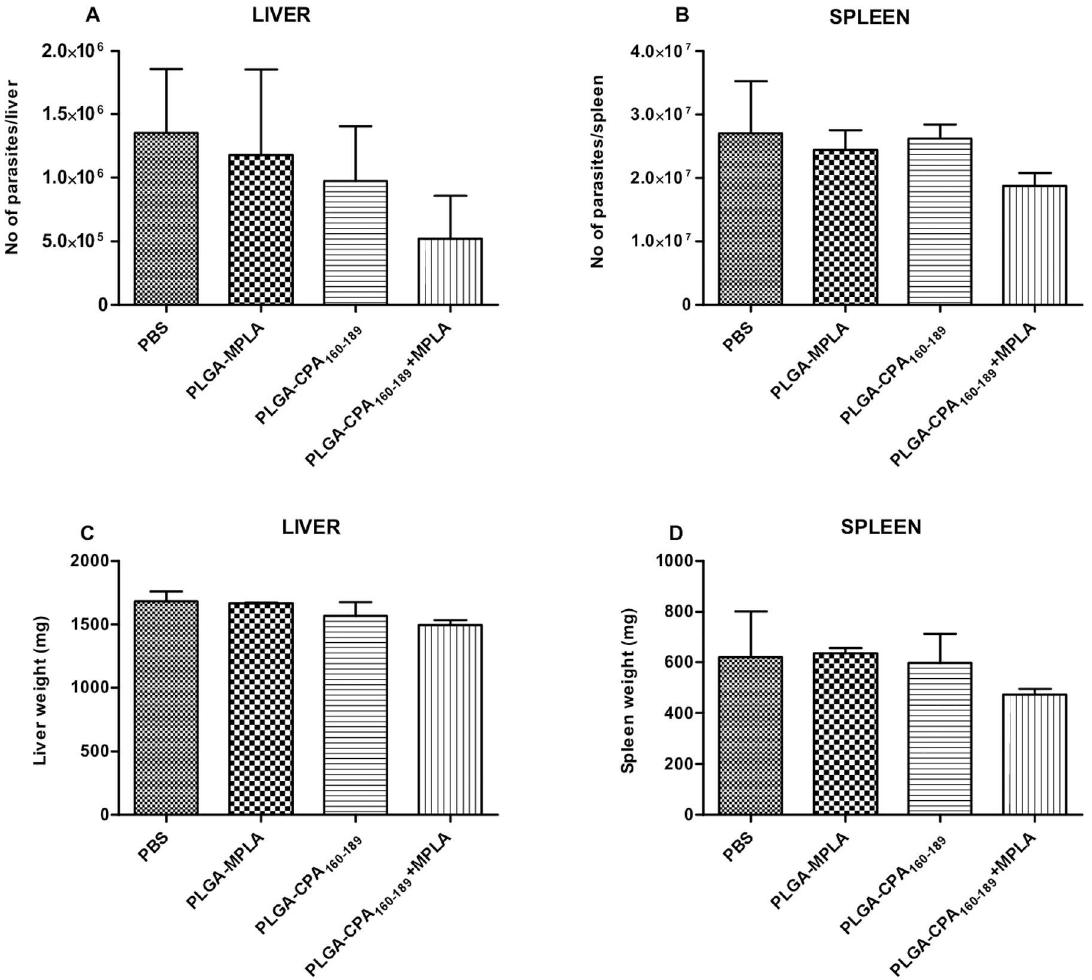
Fig 9. Evaluation of vaccine-mediated protection against L . infantum infection in BALB/c mice 4 months post intravenous challenge. Determination of (A-B) parasite load in the spleenand the liver by limitingdilutionassay and (C-D) hepatosplenomegalyin vaccinatedand non-vaccinated mice 4 months post challengewith L . infantum . Results are presented as means ± SD of five individualmice per group, representative of two independentexperiments with similar results. * p < 0.05, ** p < 0.01, *** p < 0.001were assessed by one-wayANOVA and Tukey’s